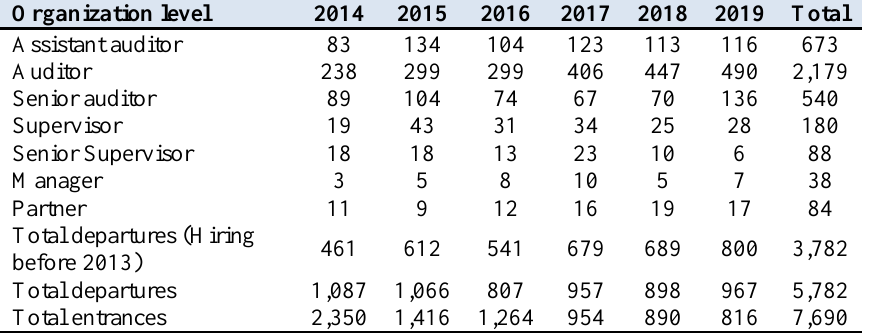
Table 1: Departure and entrance statues for employees who worked in CASEOs Organization